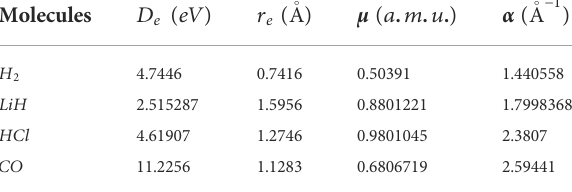
TABLE 1 Spectroscopic parameters for the selected diatomic molecule systems [45]. Molecules